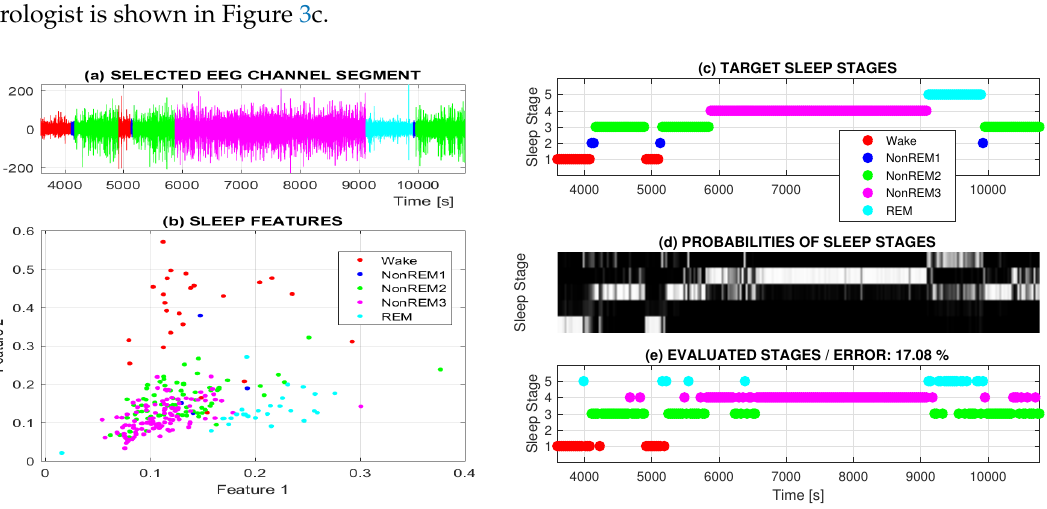
Figure 3. Two-hour long analysis presenting ( a ) EEG signal segmented into 5 classes and ( b ) features standing for the mean power in selected frequency ranges (1–4 Hz, 4–8 Hz) in subsequent 30 s long windows forming neural network pattern values; ( c ) target sleep classes forming desired neural network output; ( d ) probabilities of evaluated classes by the two layer neural network; and ( e ) resulting classes with the highest classification